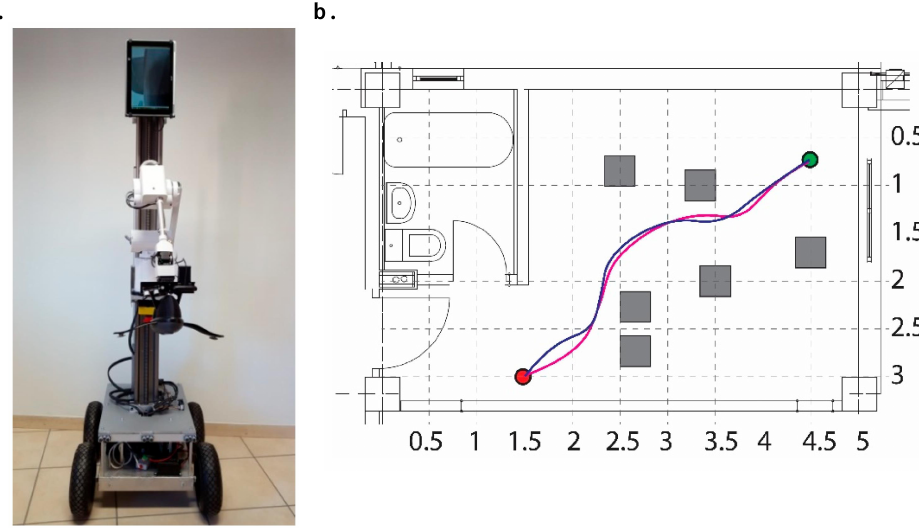
Figure 10. ( a ) Autonomous telemedicine robot system for assisted and independent living. ( b ) Simu- lated and experimental paths of an obstacle avoidance trial in a real-world scenario (center for the elderly), executed by the telemedicine robot developed in